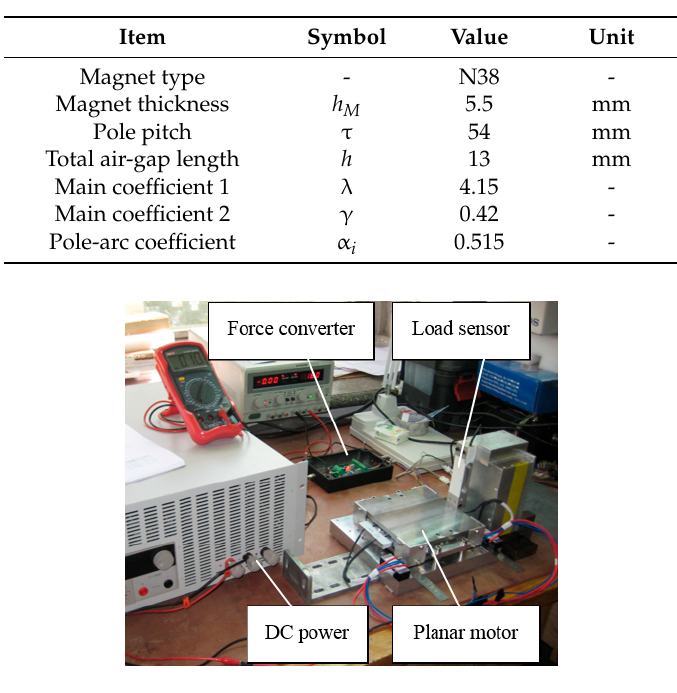
Figure 11. Inductance calculation model for the square coil.